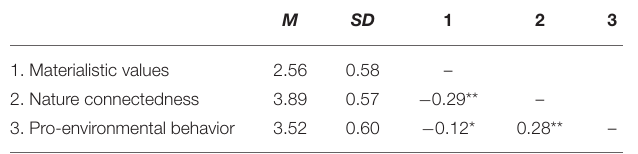
TABLE 1 | Descriptive statistics and correlation coefficients for materialistic values, nature connectedness, and pro-environmental behavior. M SD